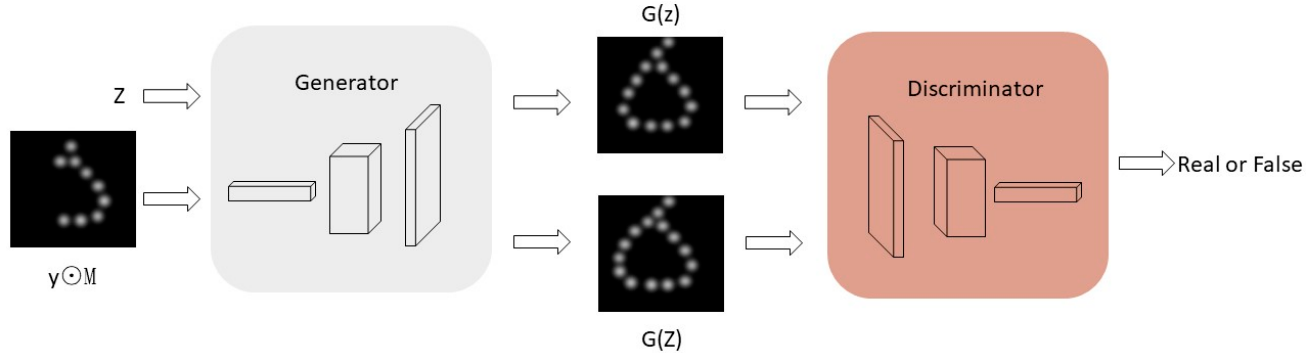
Figure 7. The principle of optical illusion point of view supplement. z is arbitrary Gaussian noise; M is the dropout part; in the binary mask, 0 indicates the dropout position of the phosphenes, and 1 indicates the retained phosphene position; y is the input image; y (cid:12) M is the image of ideal phosphenes. G ( z ) is a mapping close to the real generated image obtained from the Gaussian noise z. Z is the optimal solution. G ( Z ) is the most suitable mapping to represent the dropout part (adapted from [93]).